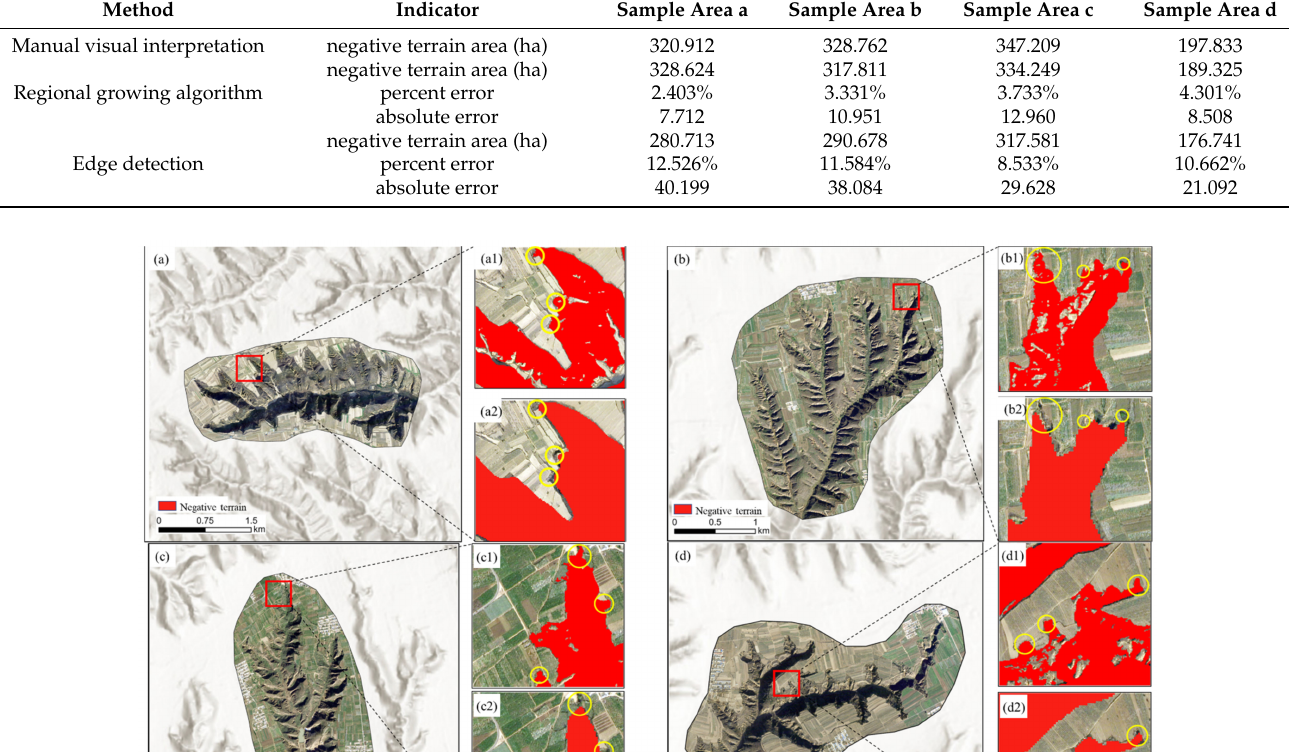
Table 2. Comparison of extracted negative terrain area with standard area differences.